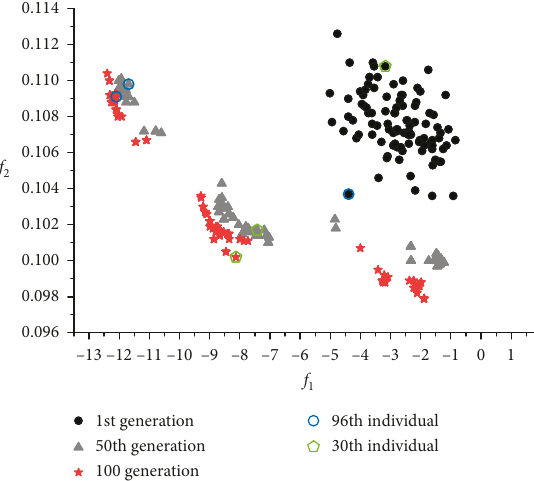
Figure 9: Population at the 1st, 50th, and 100th generation.